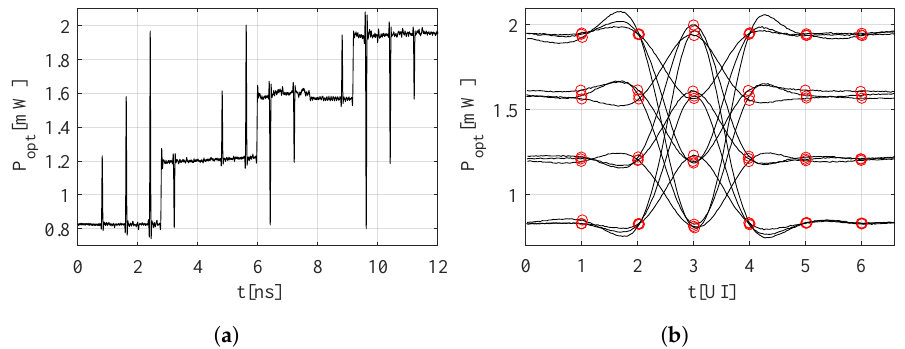
Figure 8. ( a ) Adaptive FFE training sequence, ( b ) overlaid pulse responses for all 12 combinations after